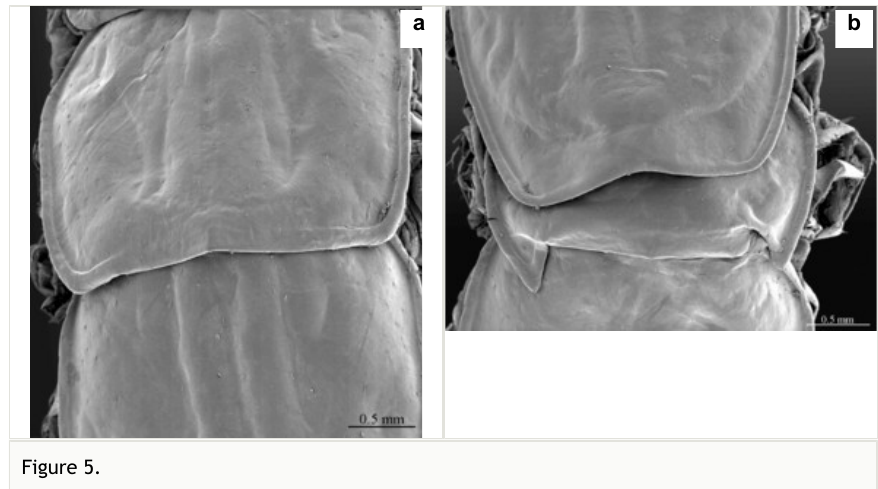
Figure 5. Eupolybothrus cavernicolus Komerički & Stoev sp. n., male paratype. a : tergite 7, dorsal view b : tergites 12-13, dorsal view